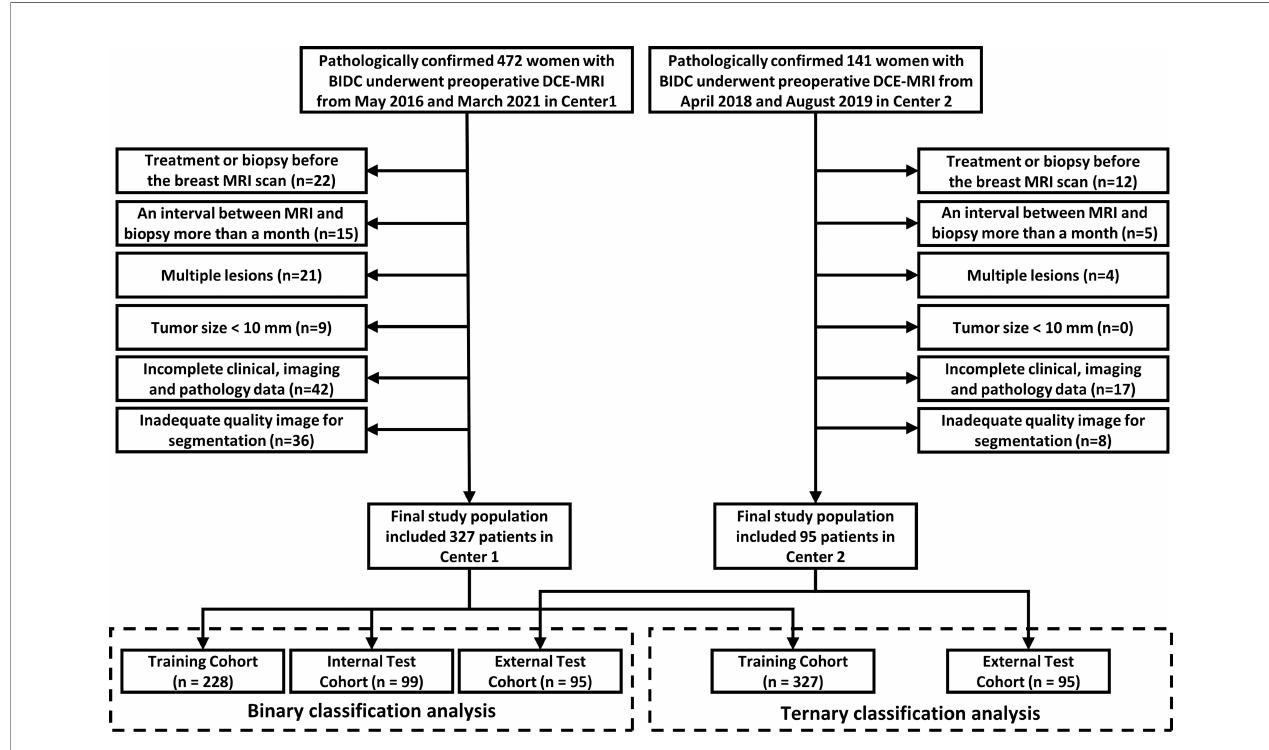
FIGURE 1 | Flow diagram of study